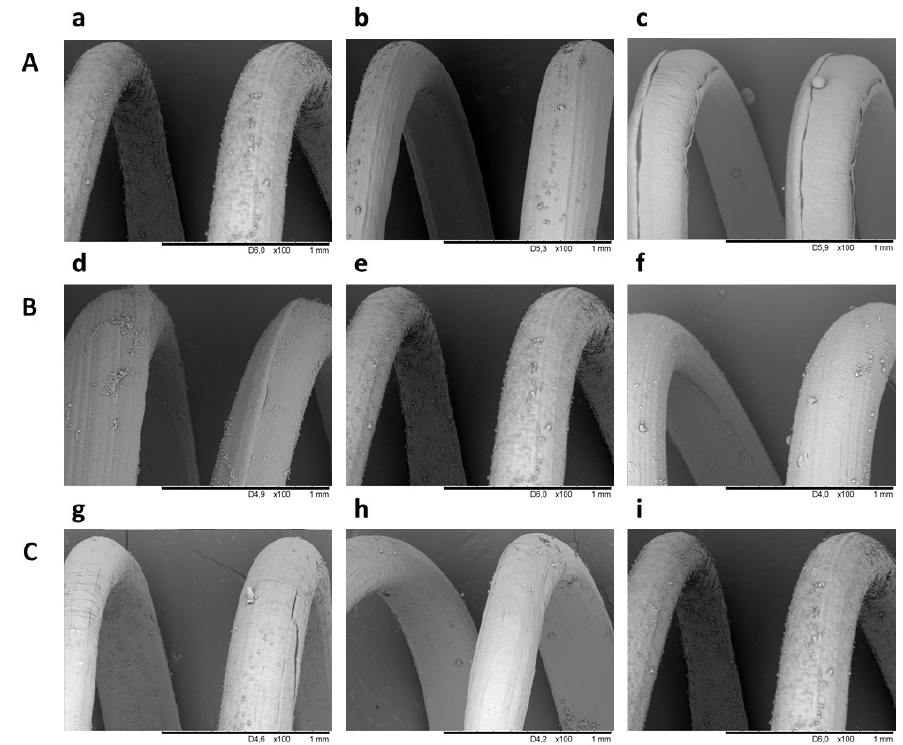
Figure 2. Scanning electron microscope images illustrating the influence of ( A ) concentration of PLGA in DCM ((a) 20%, (b) 25%, and (c) 40%), ( B ) dopamine concentration ((d) 0.2%, (e) 0.4%, and (f) 0.6%), and ( C ) microsphere concentration ((g) 1.19%, (h) 1.50%, and (i) 2.34%) on microsphere adsorption efficiency to PCL helix.